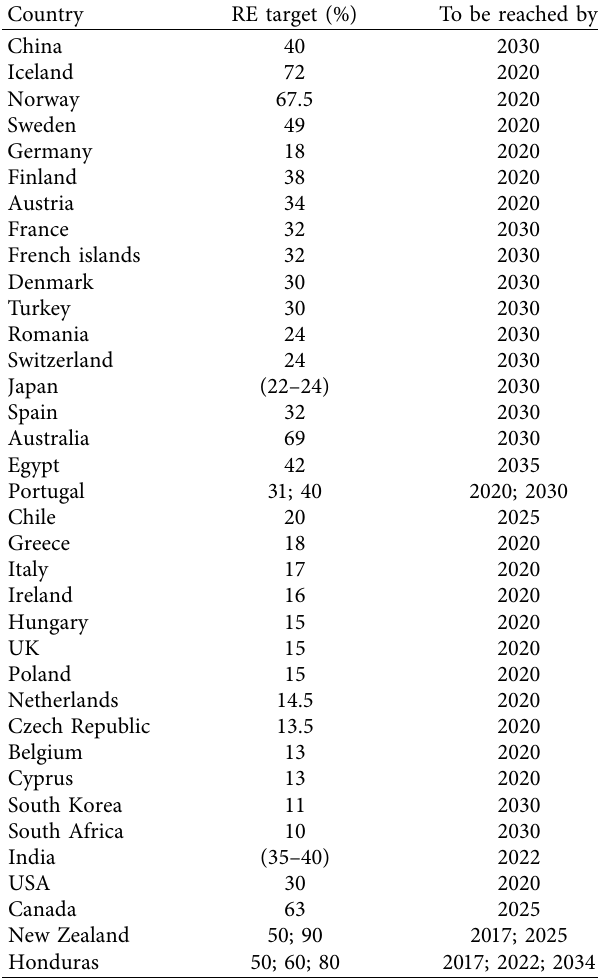
Table 1: RE targets 36 countries interested in the installation of green